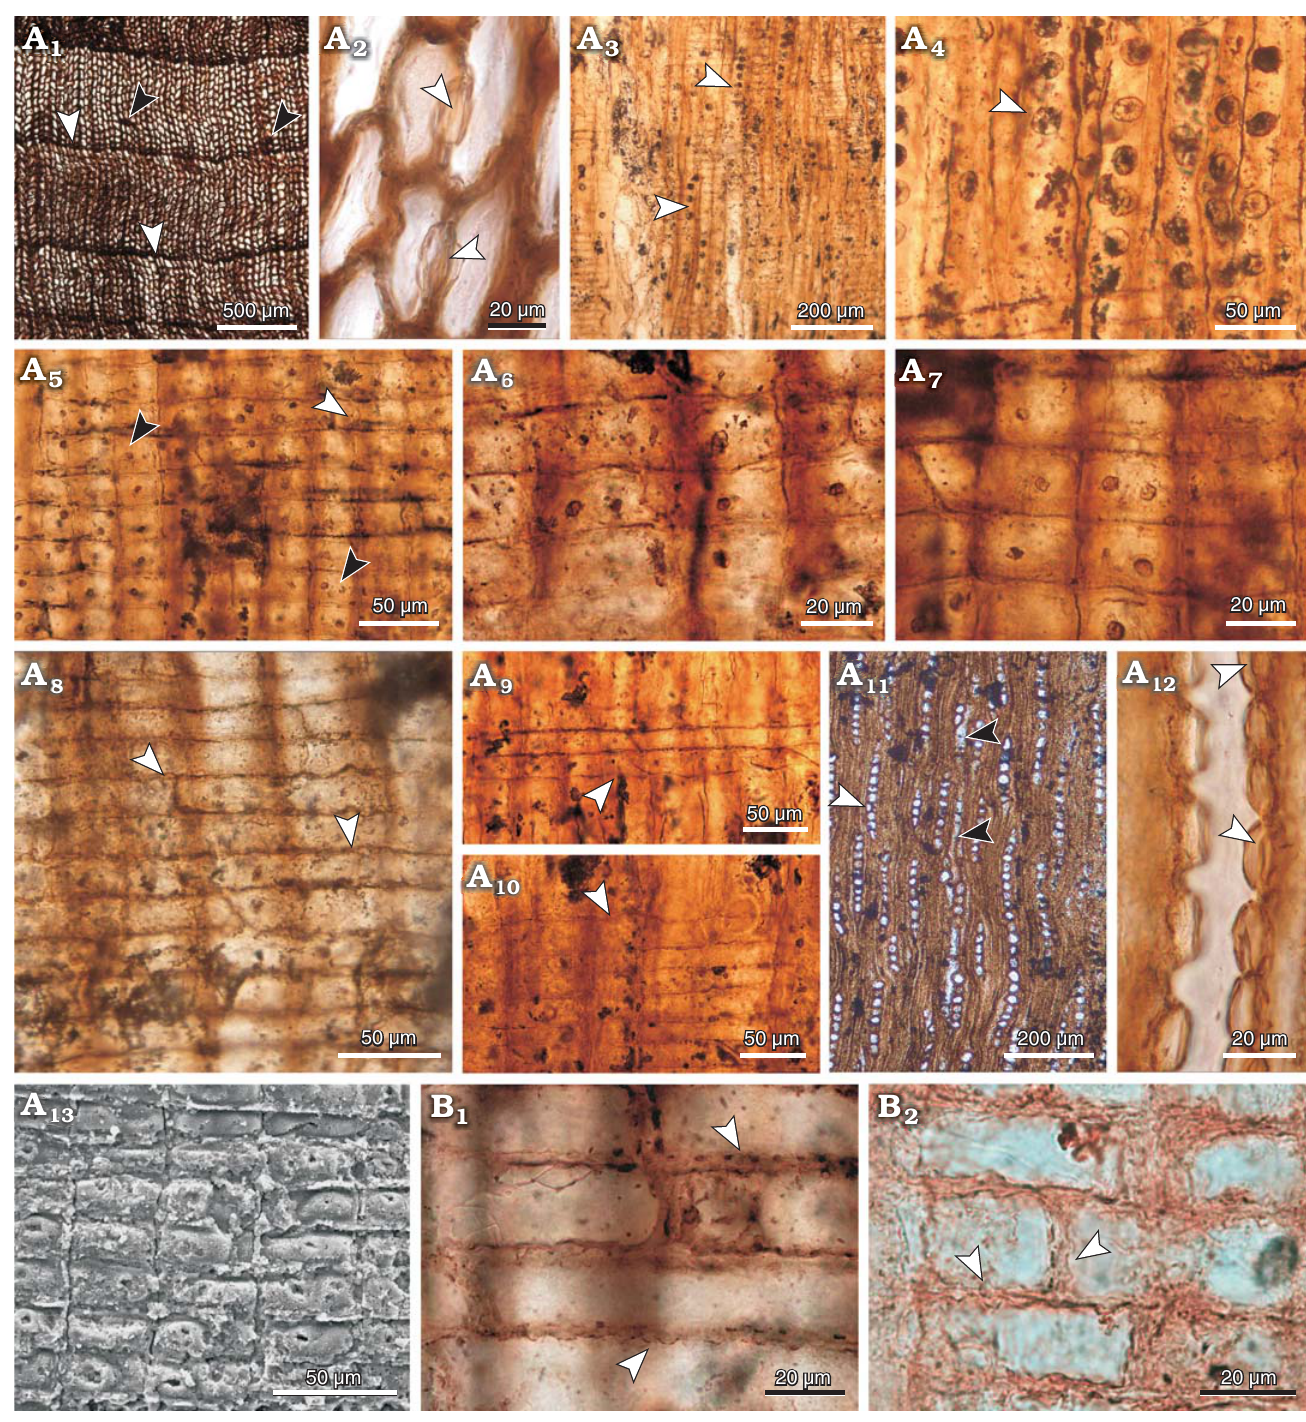
Fig. 2. Cupressaceous wood Juniperoxylon zamunerae (Bodnar, Ruiz, Artabe, Morel, and Ganuza, 2015) comb. nov. (holotype PBSJ 828, A ; PBSJ 829, B ), Cortaderita Formation, Middle Triassic of Argentina. A 1 , growth rings (white arrowheads) and axial parenchyma (black arrowheads), TS; A 2 , torus ( arrowheads), TS; A 3 , A 4 , uniseriate or rarely biseriate radial pitting on tracheid walls (arrowheads), RLS; A 5 , cupressoid cross-field pits (black arrow- heads) and nodular end walls of ray parenchyma (white arrowheads), RLS; A 6 , A 7 , detail of cross-field pits, RLS; A 8 , general view of ray parenchyma cells walls distinctly pitted (arrowheads), RLS; A 9 , A 10 , different ray parenchyma cells (arrowheads), RLS; A 11 , occasional biseriation on part of a ray (white arrowhead) and axial parenchyma (black arrowhead), TLS; A 12 , radial pits with torus (arrowheads), TLS; A 13 , cross-field with cupressoid pits, RLS. B 1 , B 2 , ray parenchyma walls distinctly pitted (arrowheads), diameter of tracheids is 26.5 μ m (10.9 − 48.9 μ m), and tra- cheid walls are 7.4 μ m (4.2 − 10.9 μ m) thick. Tracheid radial